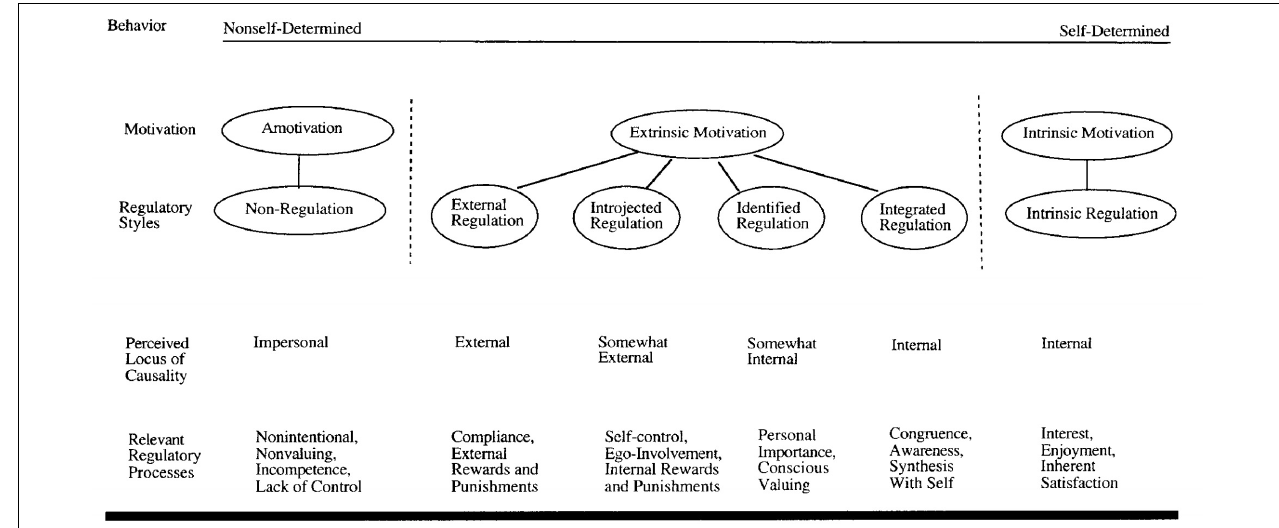
FIGURE 2 | The self-determination continuum showing types of motivation with their regulatory styles, loci of causality, and corresponding processes (from Ryan and Deci, 2000, p.